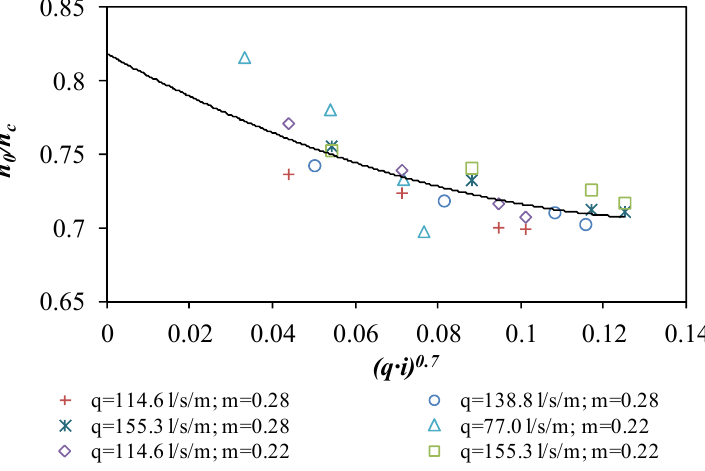
Figure 17. Adjustment of ( q ¨ i ) with ( h 0 /h c ).